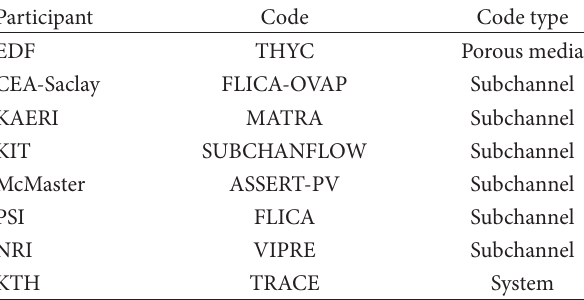
Table 17: Phase II, exercise 3